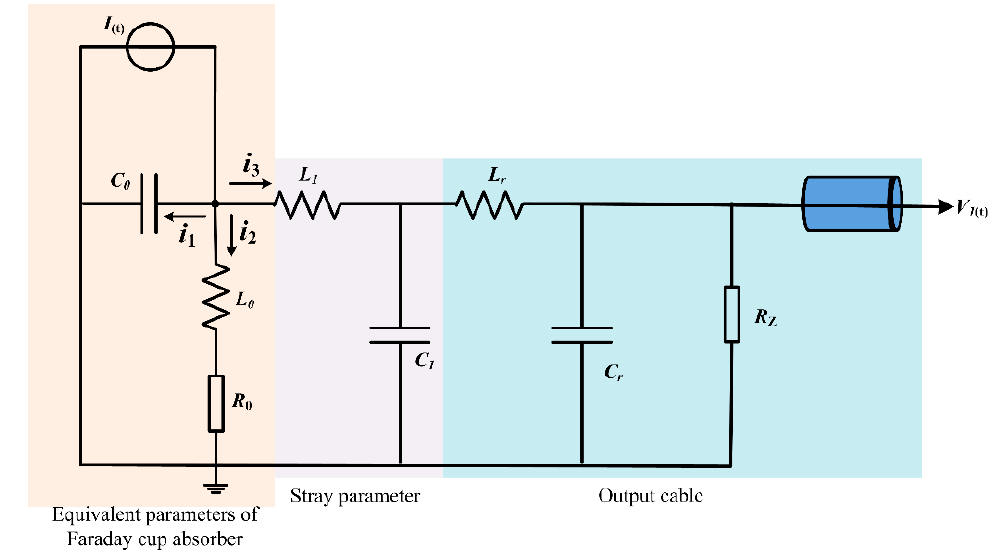
Figure 1. Equivalent circuit of full absorption Faraday cup.